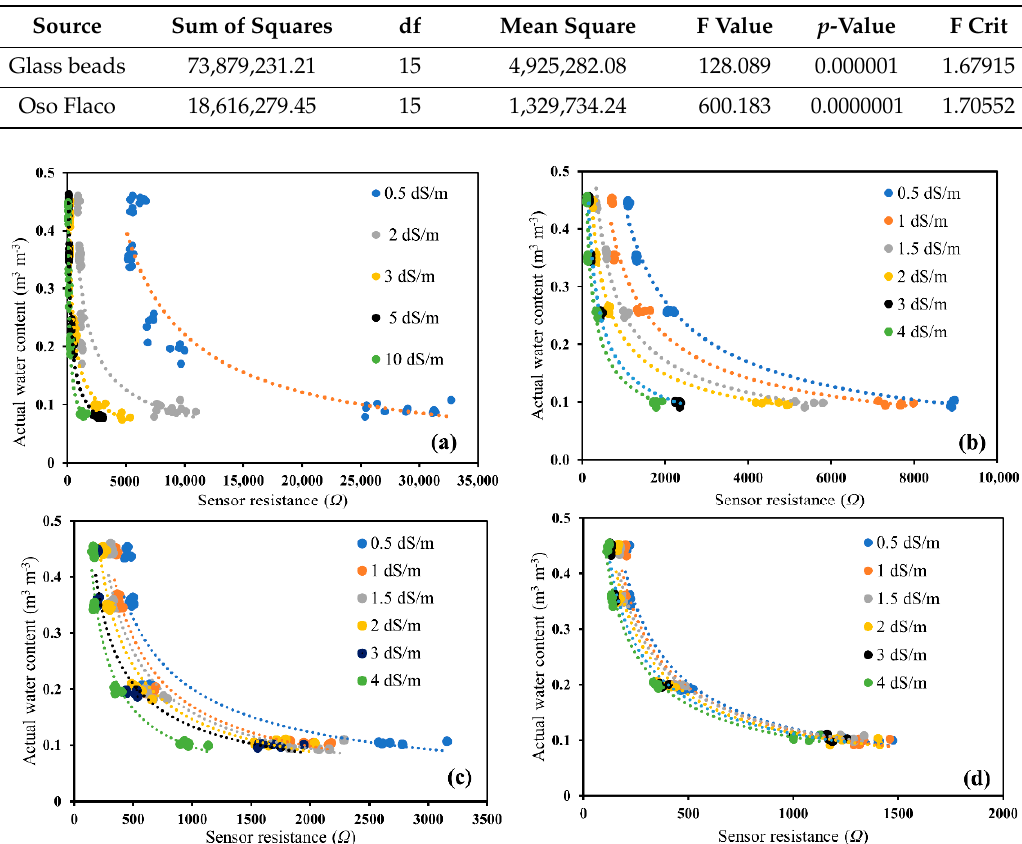
Table 3. The ANOVA for 24 h of sensor response measurements (resistance) of 15 sensors (Figure 2) in the glass beads and Oso Flaco sand.